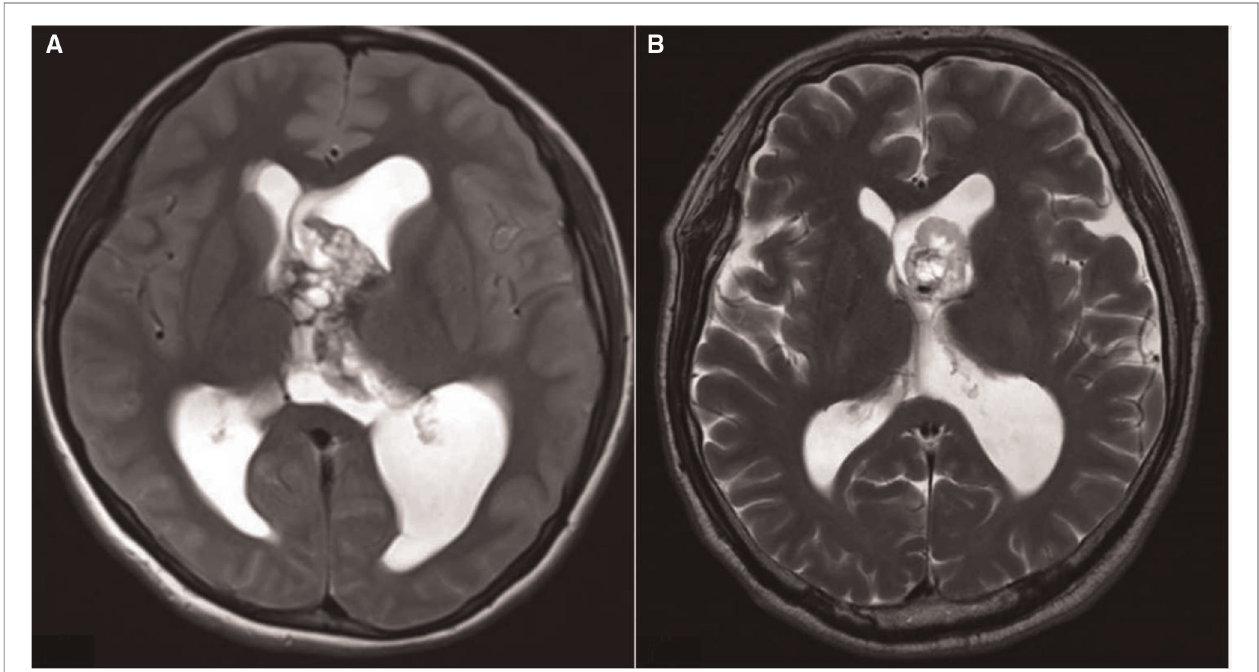
FIGURE 2 | ( A, B ) Axial T2 images showing the anterior invasion of lateral ventricular